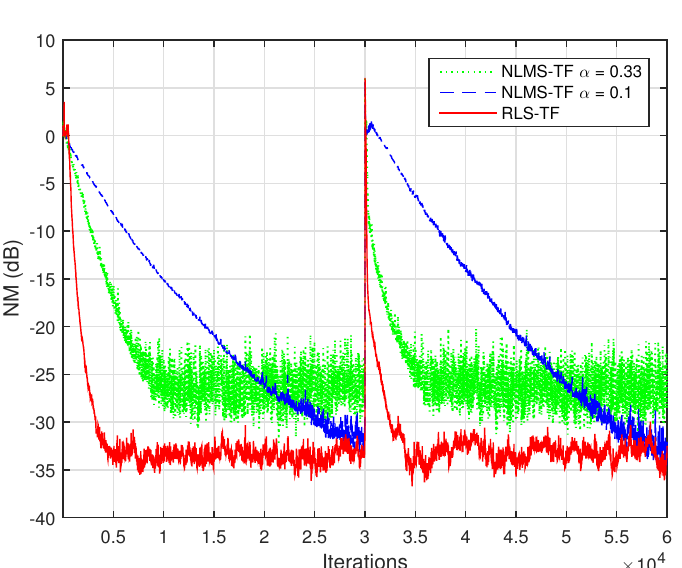
(cid:104) (cid:105) (cid:104) (cid:105) h 1 , (cid:98) h 1 ( n ) h 2 , (cid:98) h 2 ( n ) , ( b ) NPM , and ( c )